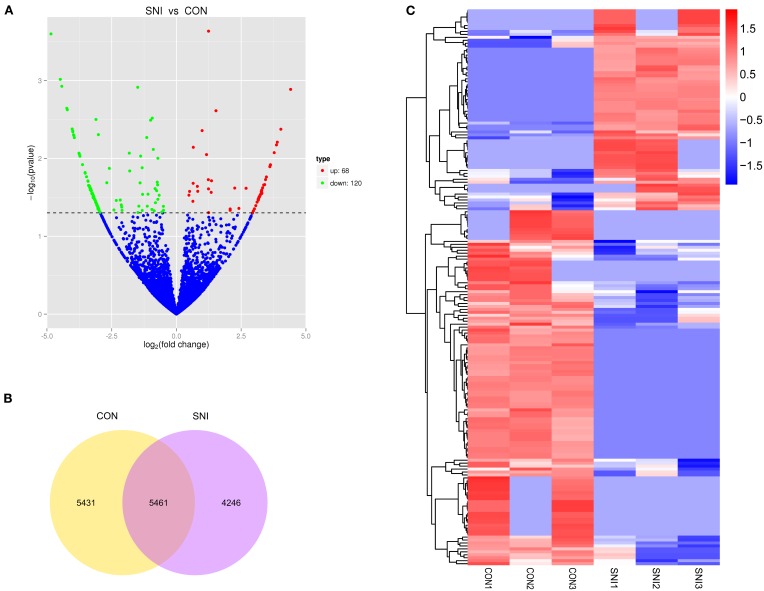
The expression profiling changes of circRNAs in spinal cord of SNI rats Vocalno Plot indicate up and down regulated circRNAs of rats in group SNI compared with group CON (A); Venn diagram showing the number of overlap circRNAs in group SNI compared with group CON (B); Heat map of circRNAs showing hierarchical clustering of changed circRNAs of rats in group SNI compared with group CON. In clustering analysis, up- and down-regulated genes are colored in red and blue, respectively (C).